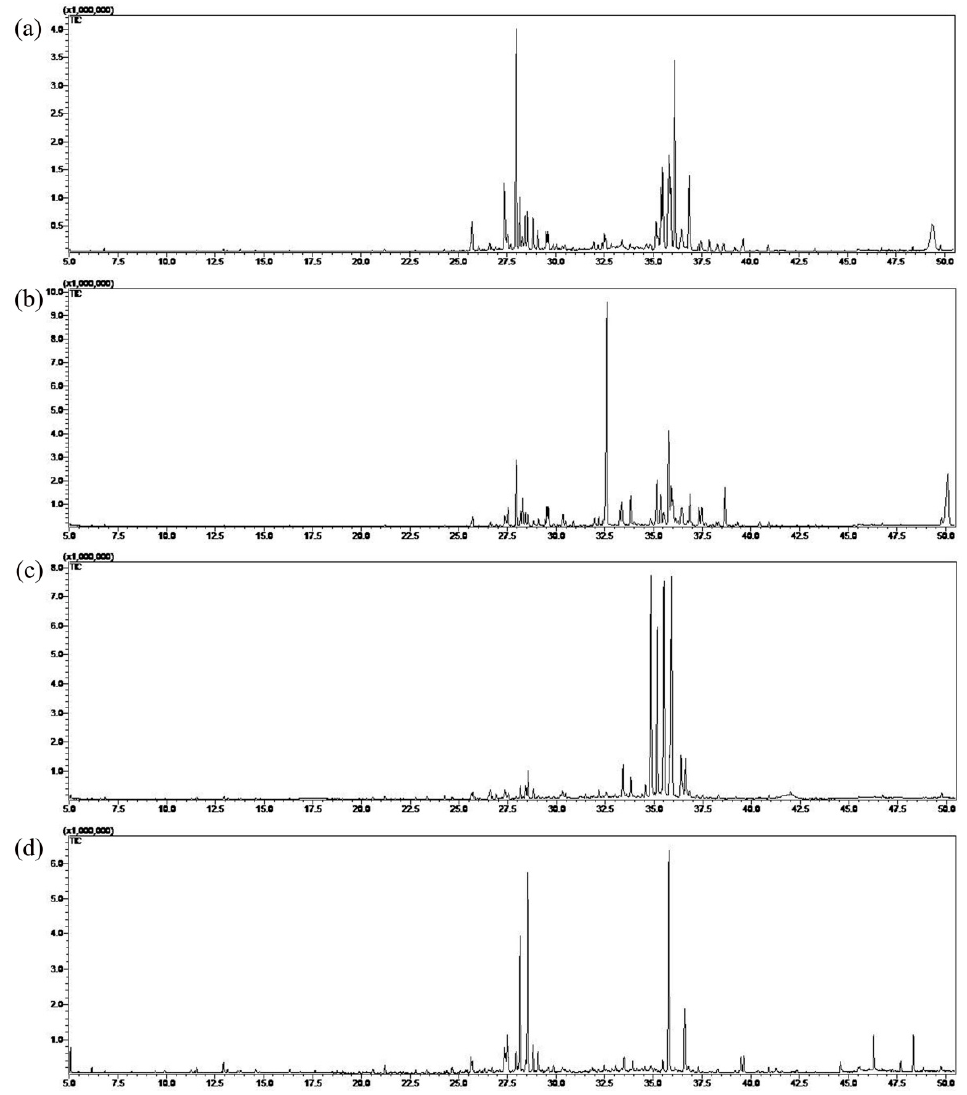
Figure 2. The total ion chromatograms of four species (( a ) SG ; ( b ) SR ; ( c ) SS ; ( d ) SP ) in Schisandra under GC-MS.